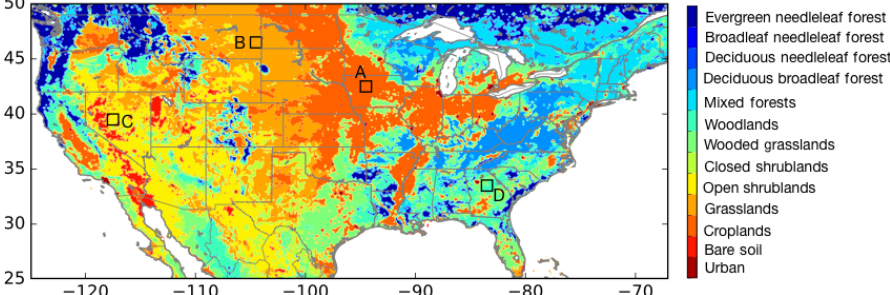
Figure 1. Map of the modeling domain with the UMD landcover classification as the background. The locations A, B, C, and D denote the areas used for time series comparisons to examine the impact from VOD DA.